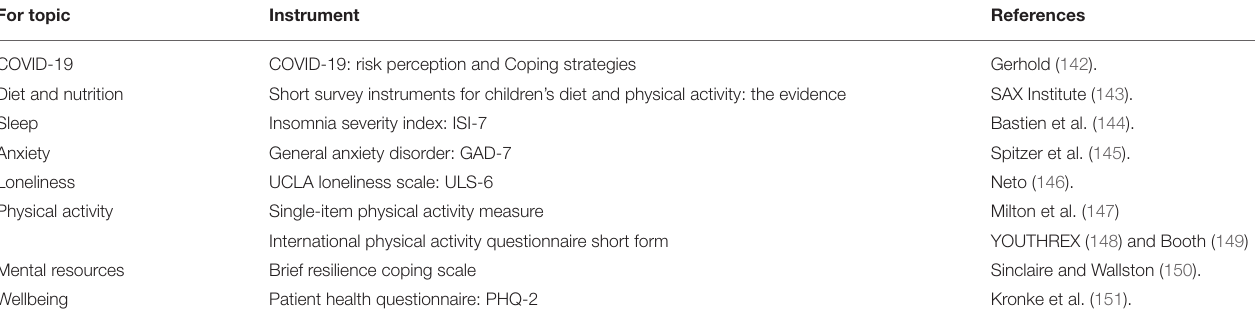
TABLE 3 | Baseline and follow-up